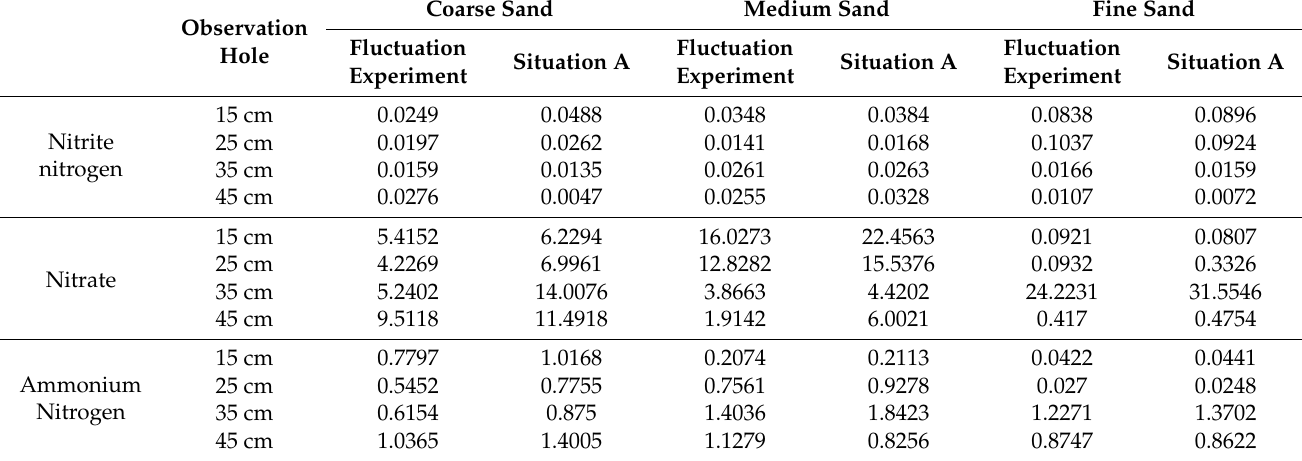
Figure 10. The measured results of fine sand and the dynamic process of nitrogen in situation A (( a ) nitrate nitrogen; ( b ) nitrite nitrogen; ( c ) ammonium nitrogen). The comparison of the standard deviation of nitrogen concentration obtained by the three media simulations is shown in Table 6. Table 6. Scenario A model standard deviation comparison.